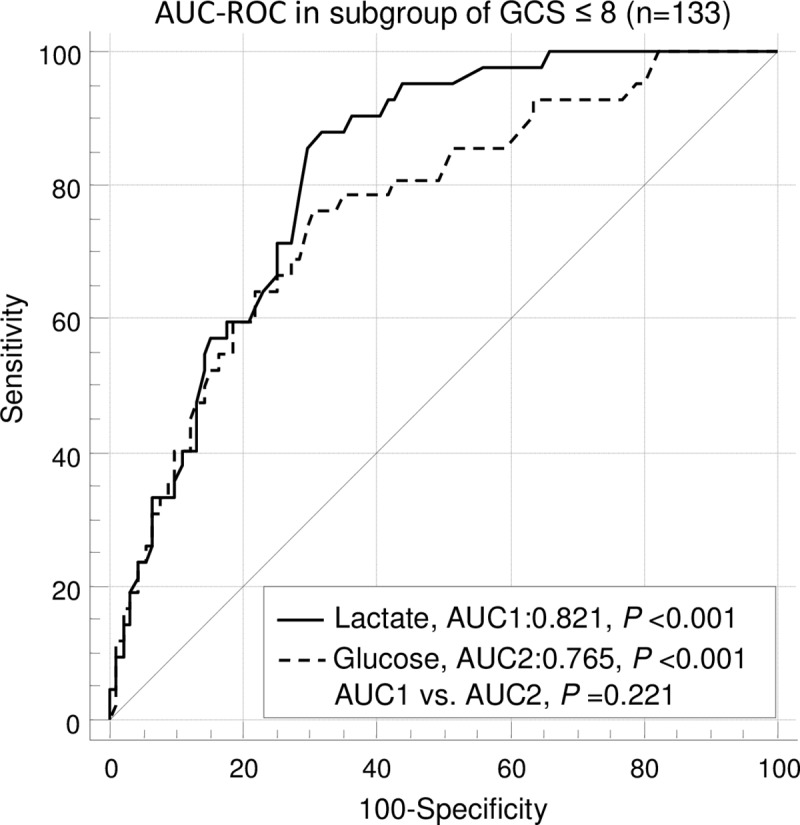
ROC curve analyses of mortality in subgroup of GCS ≤ 8.The AUC of admission lactate was not significantly different from the AUC of admission glucose. AUC- area under the curve; GCS- glasgow coma scale; ROC- receiver operating characteristic.